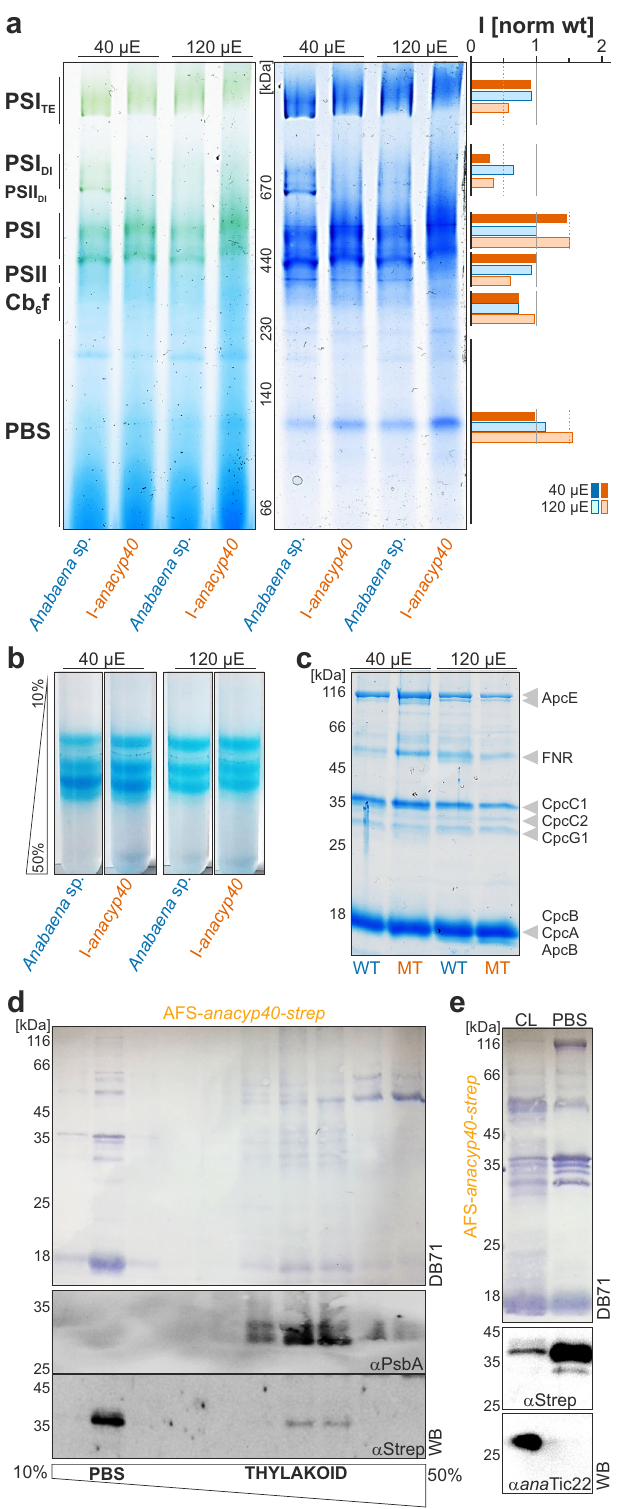
were detected in the cell lysate (Fig. 4e, CL; Supplementary Fig. 7), fraction (Fig. 4e, PBS).